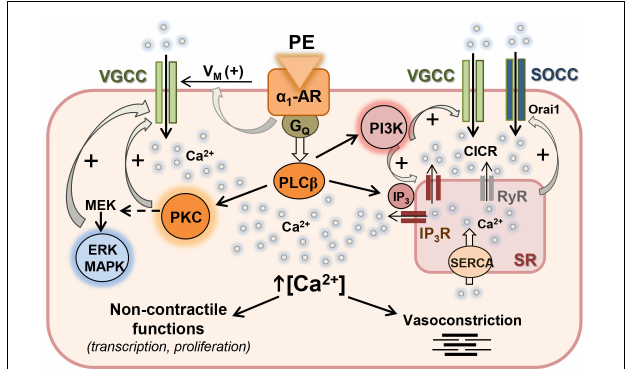
FIGURE 7 | Proposed mechanism for the regulation of Ca 2 + handling by PI3K, MAPK, and PKC in resistance arteries VSM. Activation of α 1 -adrenoceptor ( α 1 -AR) with phenylephrine (PE) is coupled to membrane depolarization (+Vm), stimulation of Ca 2 + influx through L-type voltage-gated Ca 2 + channels (VGCC) and vasoconstriction. α 1 -AR is also coupled to PLC β activation which stimulates Ca 2 + release from sarcoplasmic reticulum (RS) Ca 2 + store through IP 3 receptors (IP 3 R), and also stimulates PKC which in turn activates the MEK-ERK MAPK intracellular signaling cascade. Both PKC and ERK MAPK can directly act on L-type VGCC and reinforce Ca 2 + influx mostly related to non-contractile functions. α 1 -AR is also coupled to PI3K activation and stimulation of both IP 3 R-mediated Ca 2 + release and Ca 2 + entry through VGCC. Ca 2 + influx through VGCC amplifies Ca 2 + signal through the ryanodine receptor (RyR)-mediated Ca 2 + -induced Ca 2 + release (CICR). Emptying of the SR Ca 2 + store leads to store-operated Ca 2 + channel (SOCC) entry to refill empty